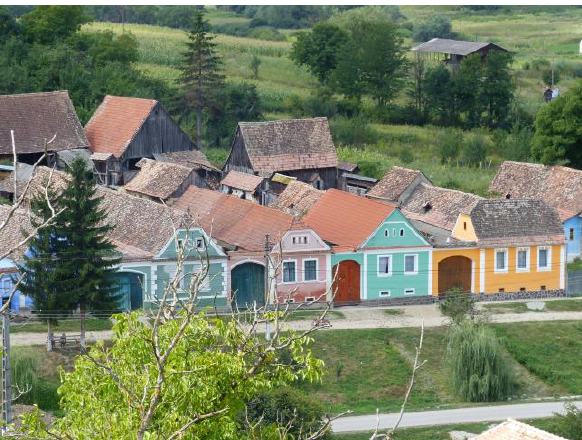
Figure 8. Dwellings in the main street of Viscri.